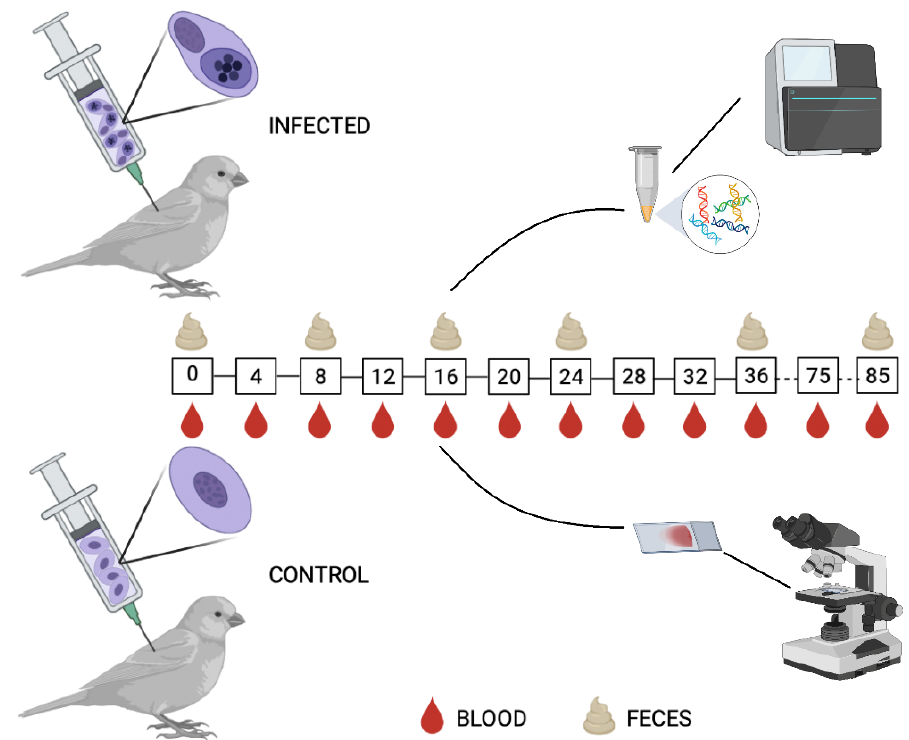
Figure 1. Experimental design. Canaries were inoculated with P. homocircumflexum- infected ( n = 8) or uninfected ( n = 8) donor blood. Blood and fecal samples were collected at different time points as indicated. Created with BioRender.com.